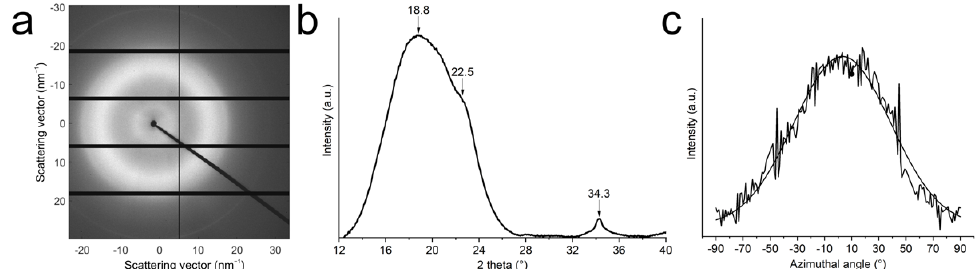
Figure 7. Analysis of filament alignment in the composites using 2D-WAXS. The meridional direction coincides with the freezing direction during ice-templating, i.e., the filament direction. ( a ) A representative diffractogram of a 1.1 µm filament/epoxy composite. ( b ) Radial integration of the diffractogram after baseline subtraction. ( c ) Azimuthal integration of the (004) plane. The zero degree was set on meridian.